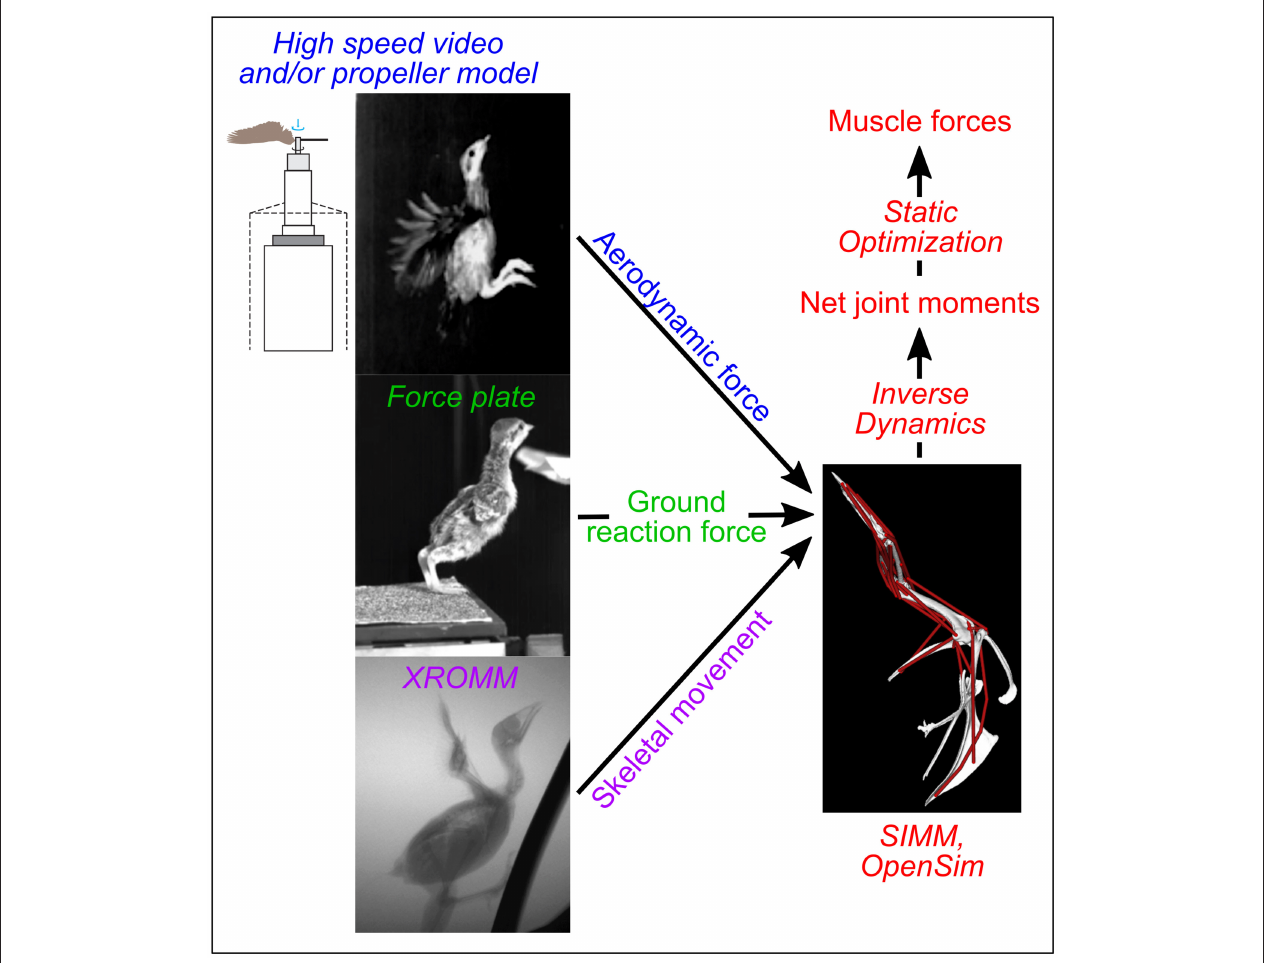
FIGURE 1 | Modeling overview. Colors indicate different types of data used as simulation inputs or outputs; techniques used to collect or simulate each type of data are italicized. SIMM, Software for Interactive Musculoskeletal Modeling; XROMM, X-ray Reconstruction of Moving Morphology. The drawing of a propeller apparatus is modified from Crandell and Tobalske